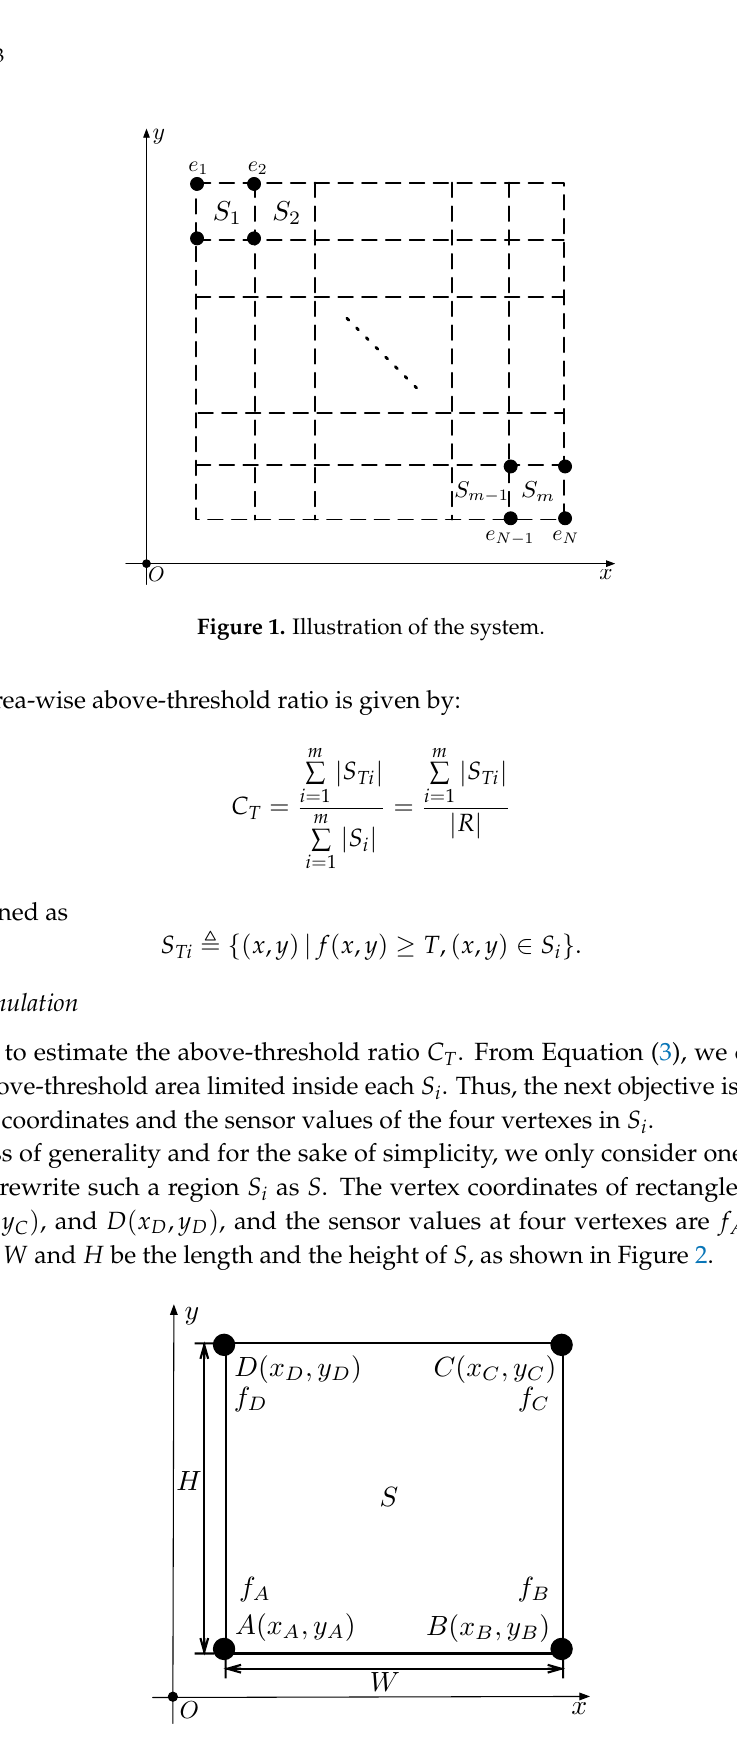
Figure 2. Illustration of rectangle subregion